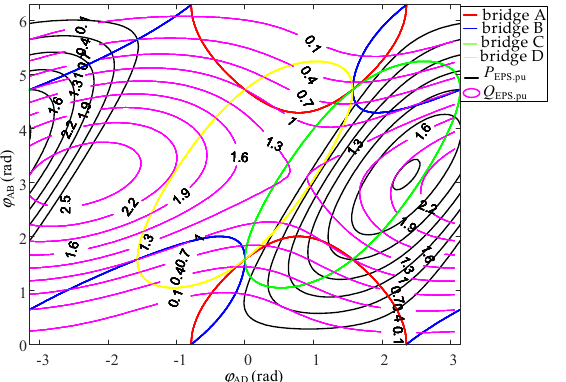
Figure 10. Intersection of active power and reactive power contours under DPS modulation ( M = 1).